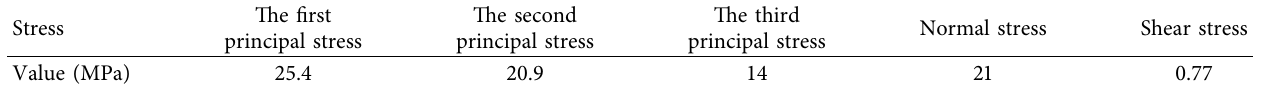
Table 4: Geostress input for calculation of right bank powerhouse.